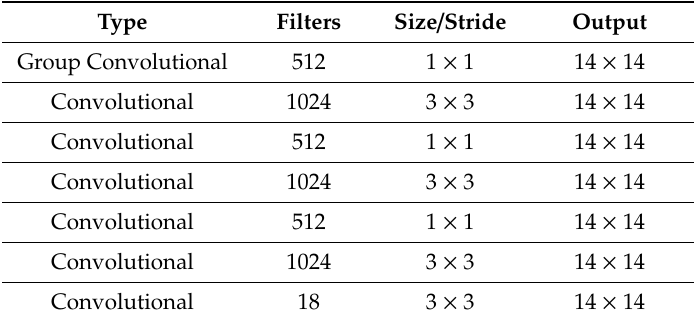
Table 7. Configuration of pass through design for tiny